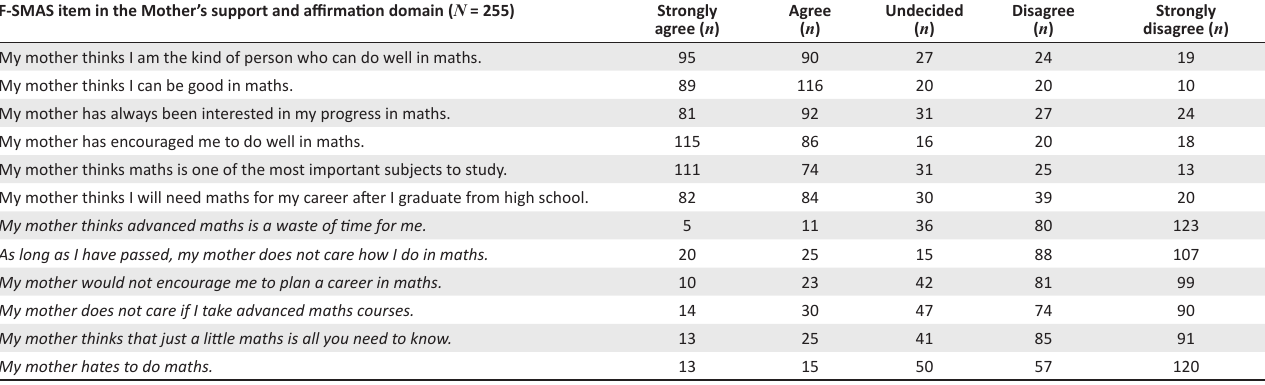
TABLE 5: Number of pre-service teachers selecting each level of agreement on mother support and affirmation scale. F-SMAS item in the Mother’s support and affirmation domain ( N = 255)